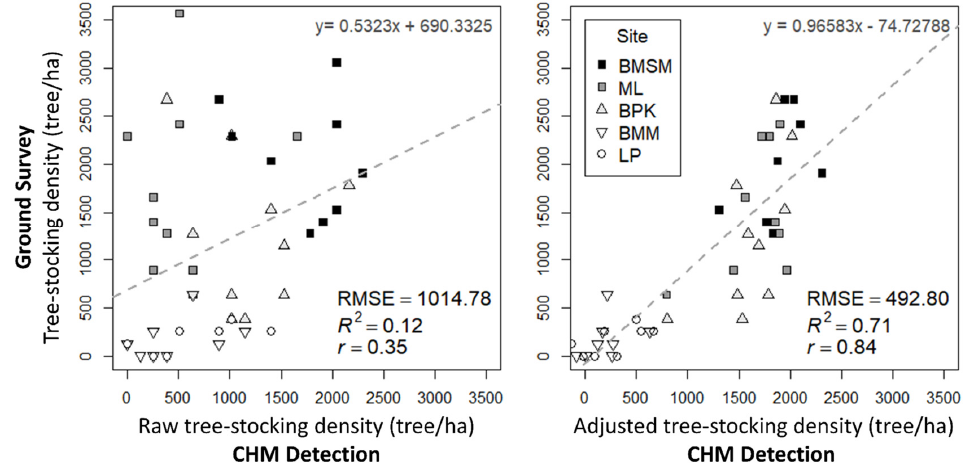
Figure 7. Stocking density (stems/ha), extrapolated from circular sample plots (5 m radius) from ground-based tree counts vs. drone imagery (tree-top counts from crown height models ( left ) and a multiple regression model combining tree-top counts and canopy density ( right ). RMSE = root mean square error; r = Pearson’s correlation coefficient. Each point represents one circular sample plot. Sites are indicated by the shape and shading of the points. Relative cover of the three ground-cover elements (tree canopy cover, ground vege- tation, and exposed soil + rock) (Figure 8) detected from drone-derived data were all highly correlated with ground-survey data. Percent canopy cover was the most highly correlated ( R 2 = 0.83), followed by ground vegetation ( R 2 = 0.71), and exposed soil + rock ( R 2 = 0.56) (Figure 9).